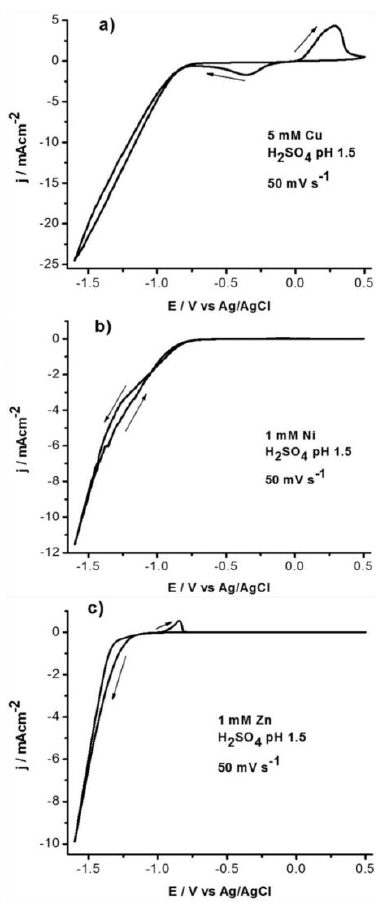
Figure 2. Cyclic voltammetries for: ( a ) 5 mM of Cu; ( b ) 1 mM of Ni and; ( c ) 1 mM of Zn, in H 2 SO 4 , pH 1.5 solution. Scan rate of 50 mV · s − 1